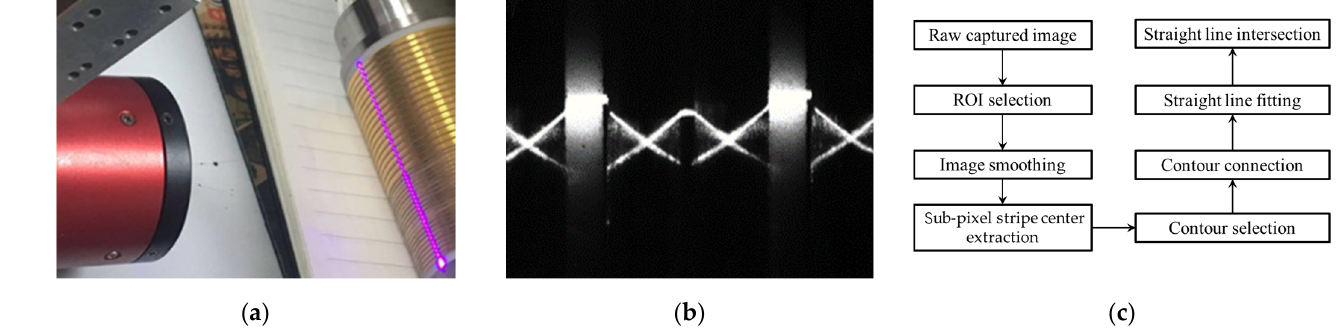
Figure 4. Measurement of the slip ring groove position: ( a ) Line laser projected onto the groove surface; ( b ) Captured laser line image on the groove side walls; ( c ) Flow diagram of the image processing to measure the groove position.